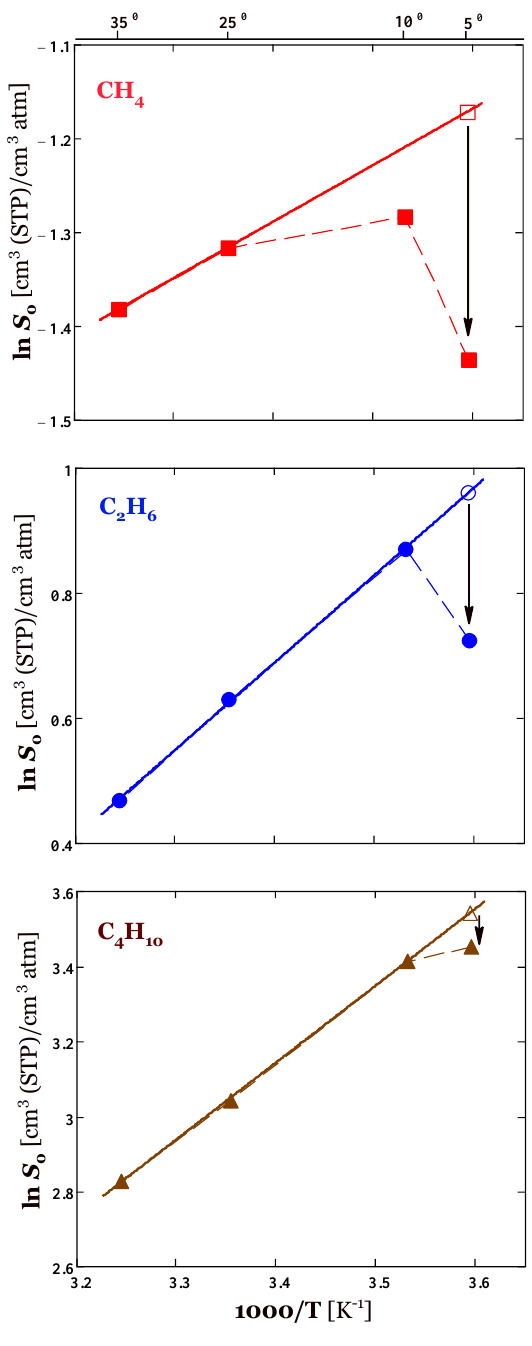
Figure 3. Temperature dependence of methane, ethane, and n -butane solubility coefficients in the limit p → 0. The filled symbols represent values of the Henry constants S 0 , solid lines represent the linear fits to the experimental data using the van’t Hoff relationship. The extrapolated solubility value at 5 °C is indicated by an open symbol for each sorbate. Arrows show the drop in gas solubility in a hypothetical amorphous rubber over that of semi-crystalline polymer at 5 °C.